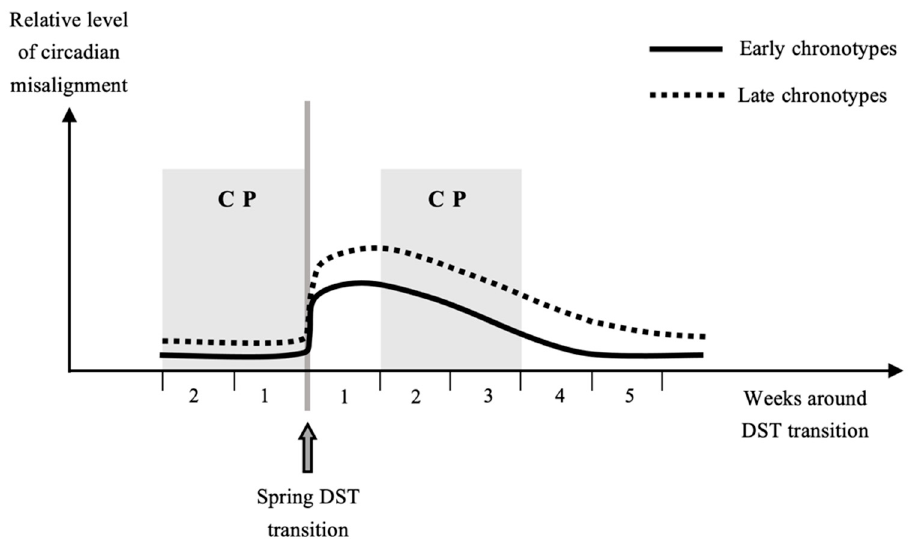
Figure 1. Circadian misalignment in relation to the spring daylight saving time (DST) transition in early and late chronotypes. Late chronotypes at baseline have relatively greater levels of circadian misalignment. Control periods (CPs) are shown as applied in the majority of studies on the post- DST incidence of acute myocardial infarction. Physiological adaptation is expected to be longer, in late chronotypes more than four weeks, and the two post-transitional CP weeks fall within this period. Instead of being used as CP, those weeks could represent the hazard period of an increased cardiovascular risk.